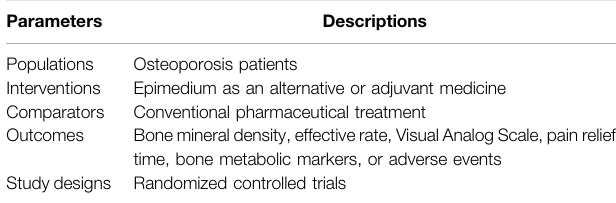
TABLE1| Populations,interventions,comparators,outcomes,andstudydesigns (PICOS) of the research question.